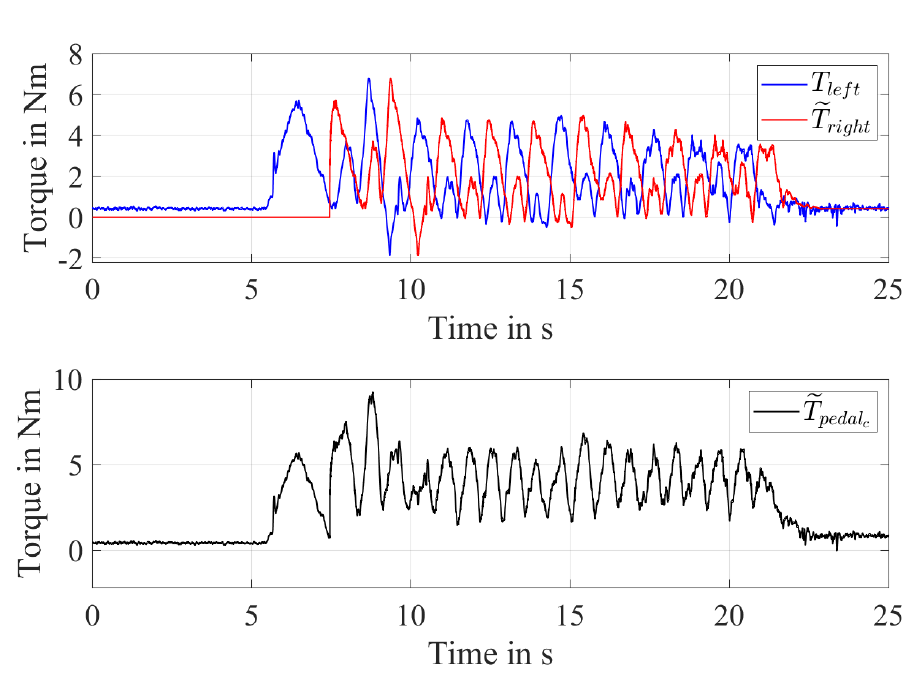
Figure 9. Pedalling torque